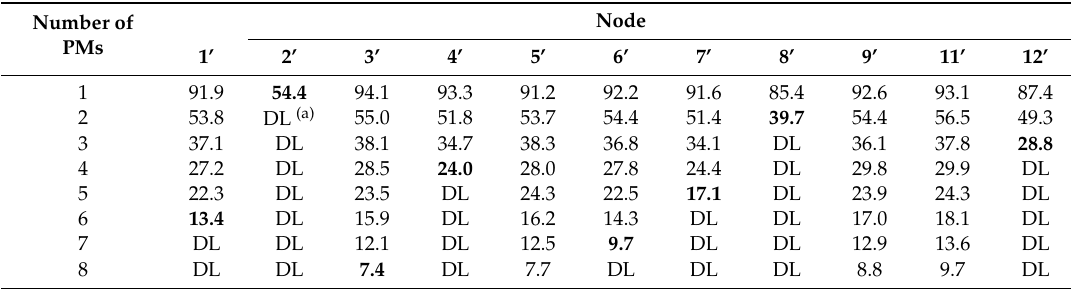
Table 3. Sensitivity index as a percentage of the total power of the AUSL feeder when the PMs are moved between nodes.